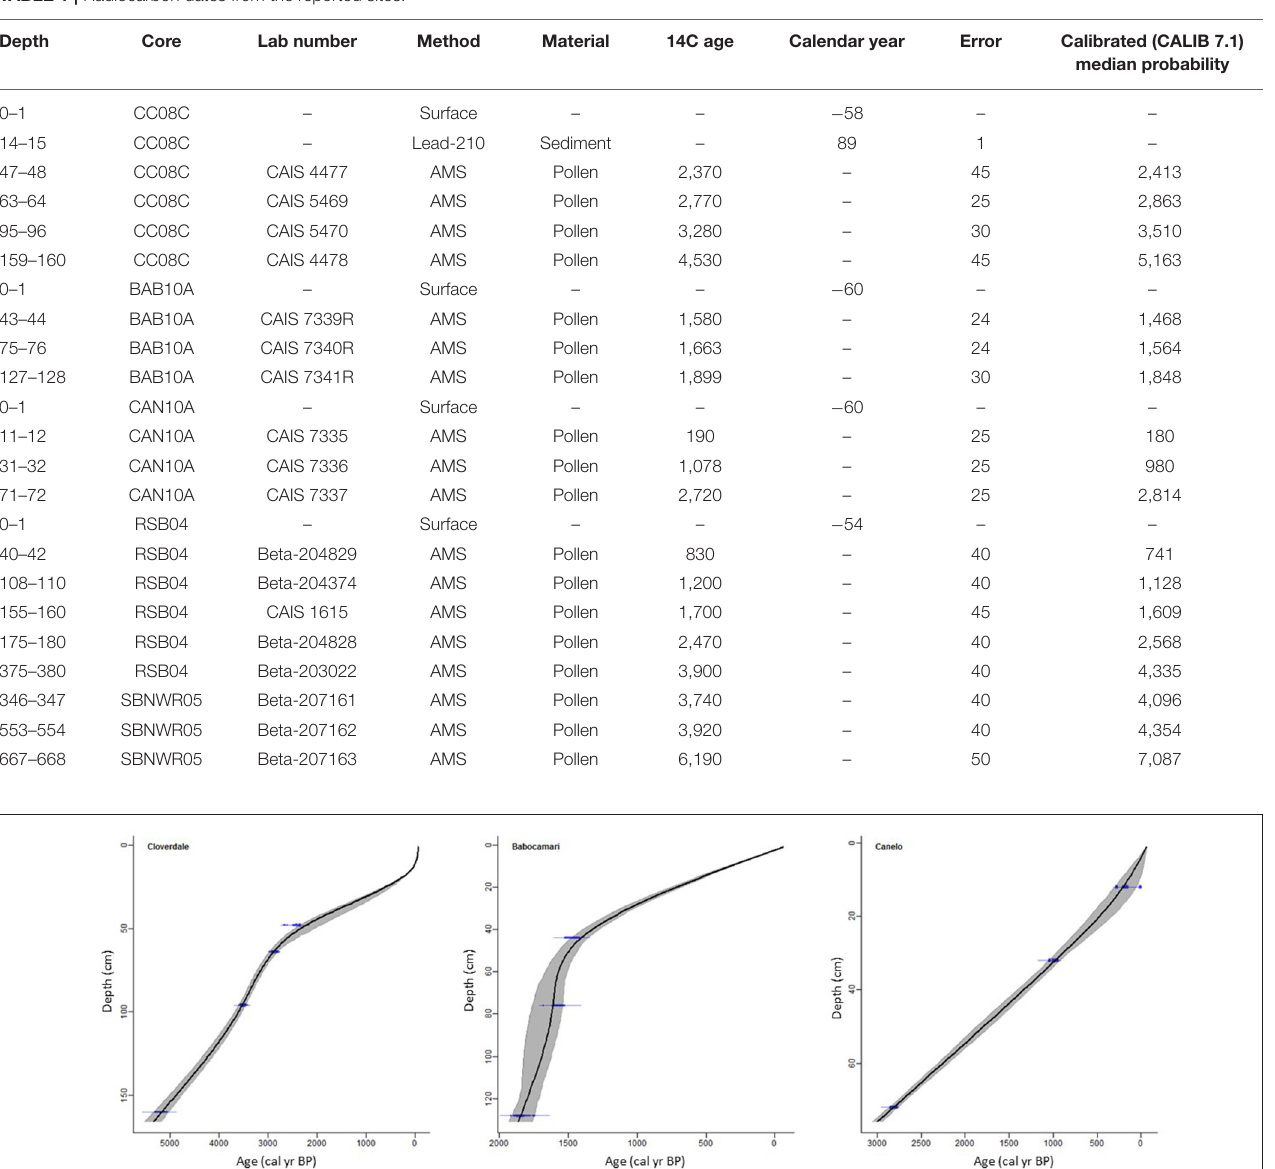
FIGURE 2 | Age models for previously unpublished